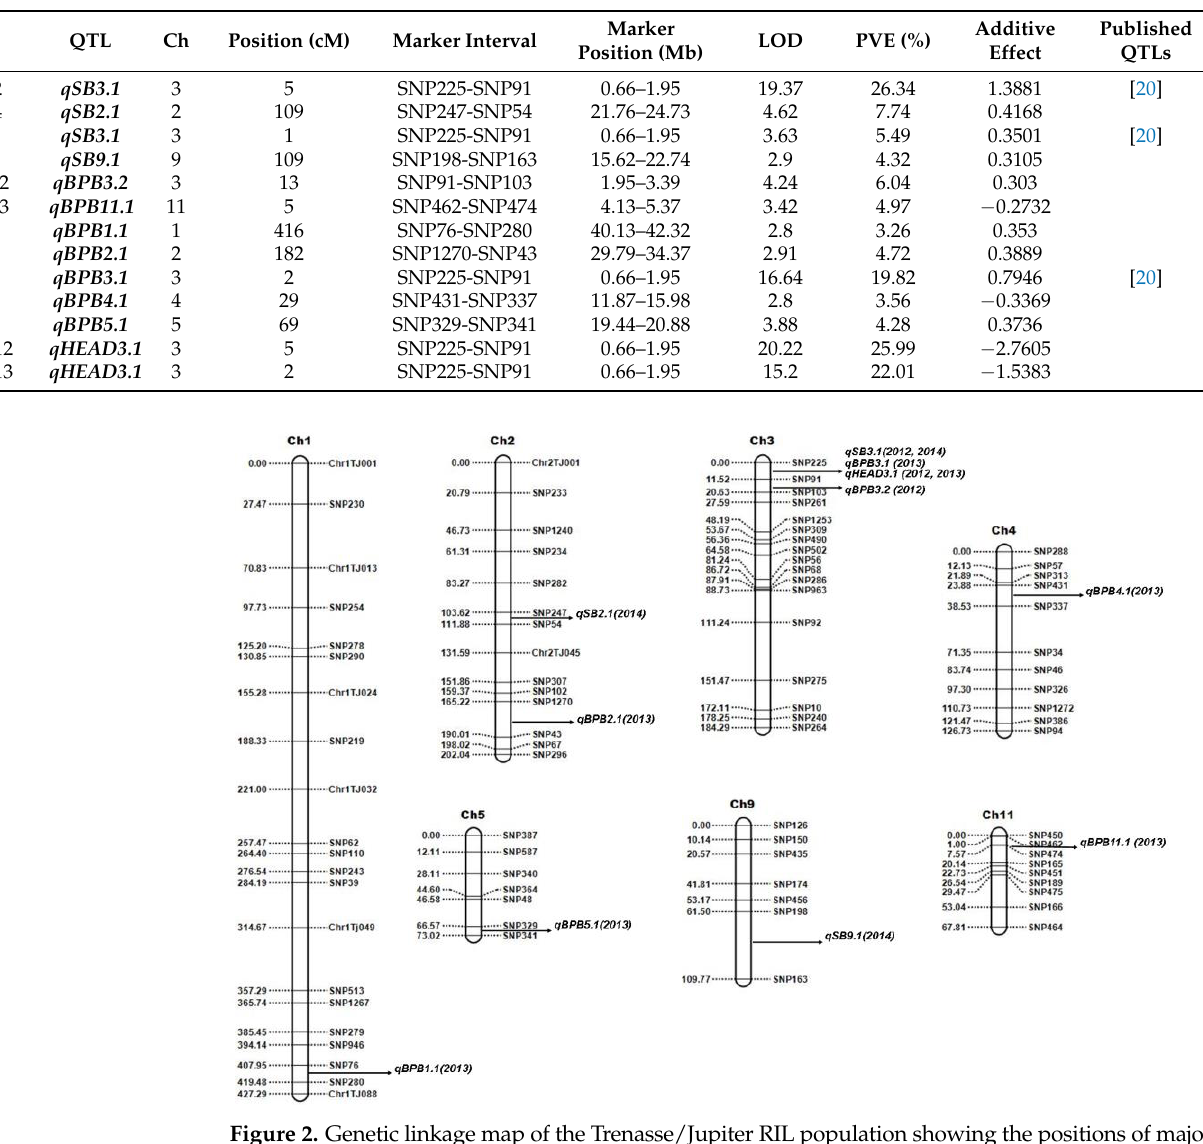
Figure 2. Genetic linkage map of the Trenasse/Jupiter RIL population showing the positions of major and minor QTLs for bacterial panicle blight, sheath blight (SB), and days to 50% heading (DTH). QTLs were detected by inclusive composite interval mapping using QTL IciMapping software v.